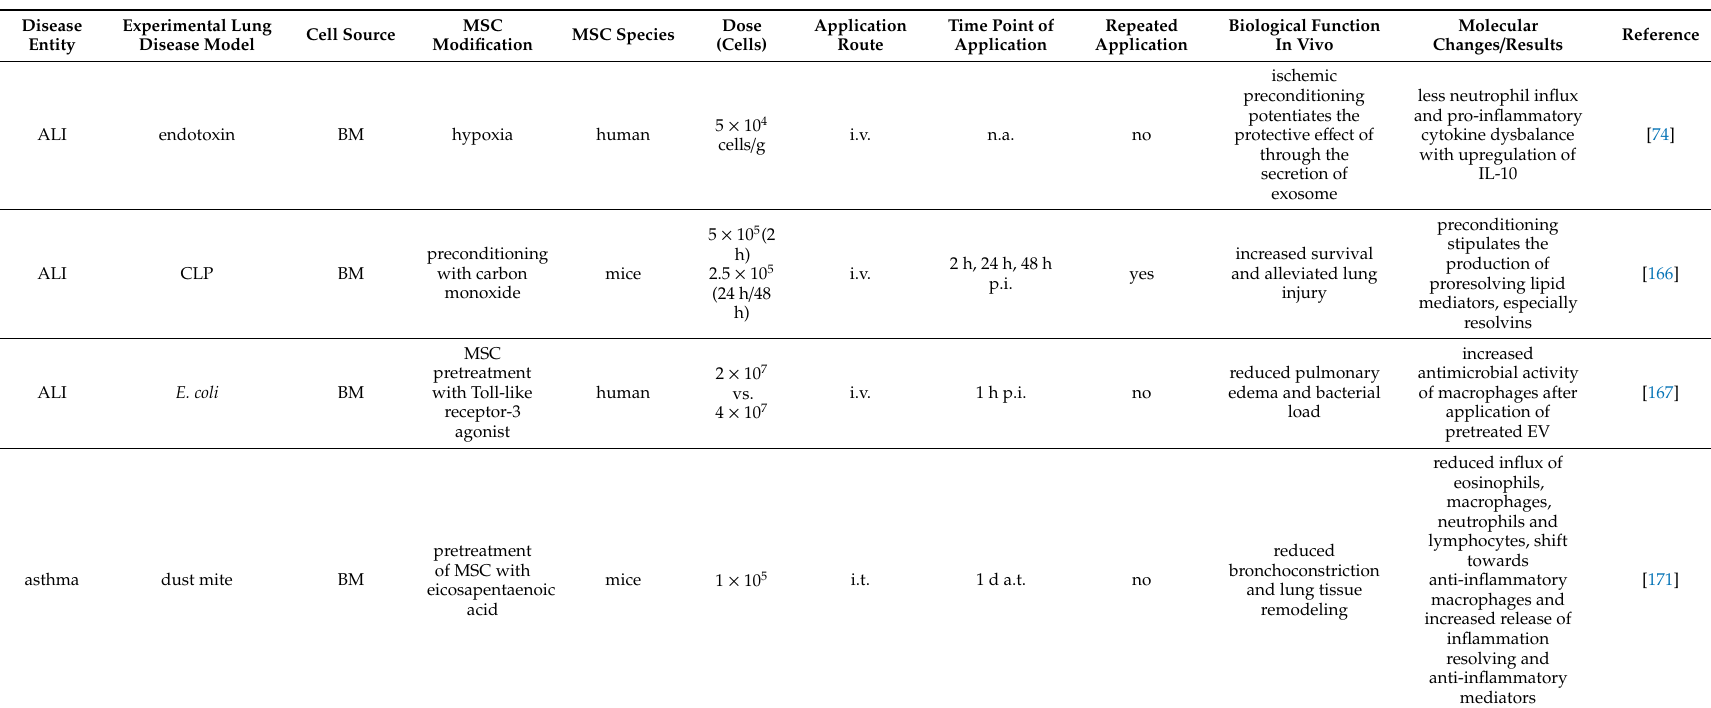
Table 7. Summary of relevant preclinical studies in rodents intended to improve the therapeutic e ffi cacy by MSC